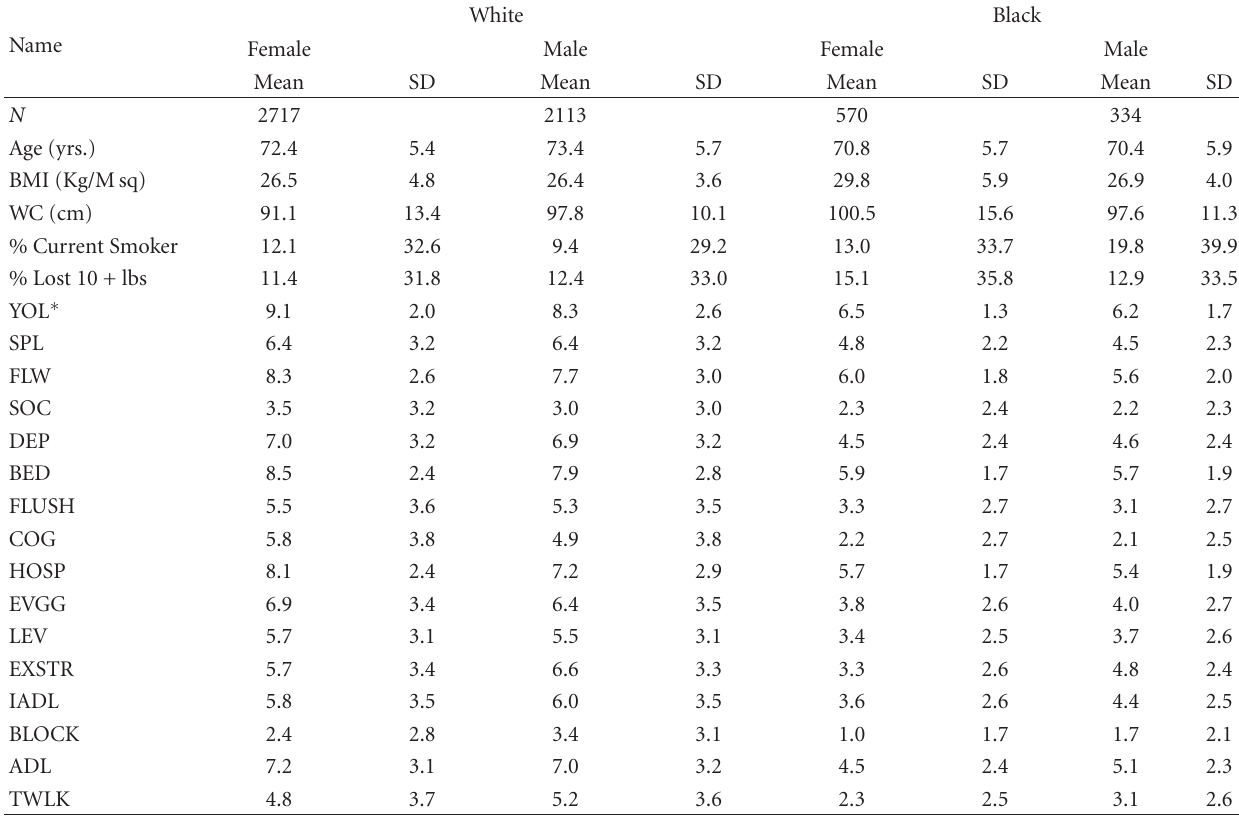
Table 2: Means and standard